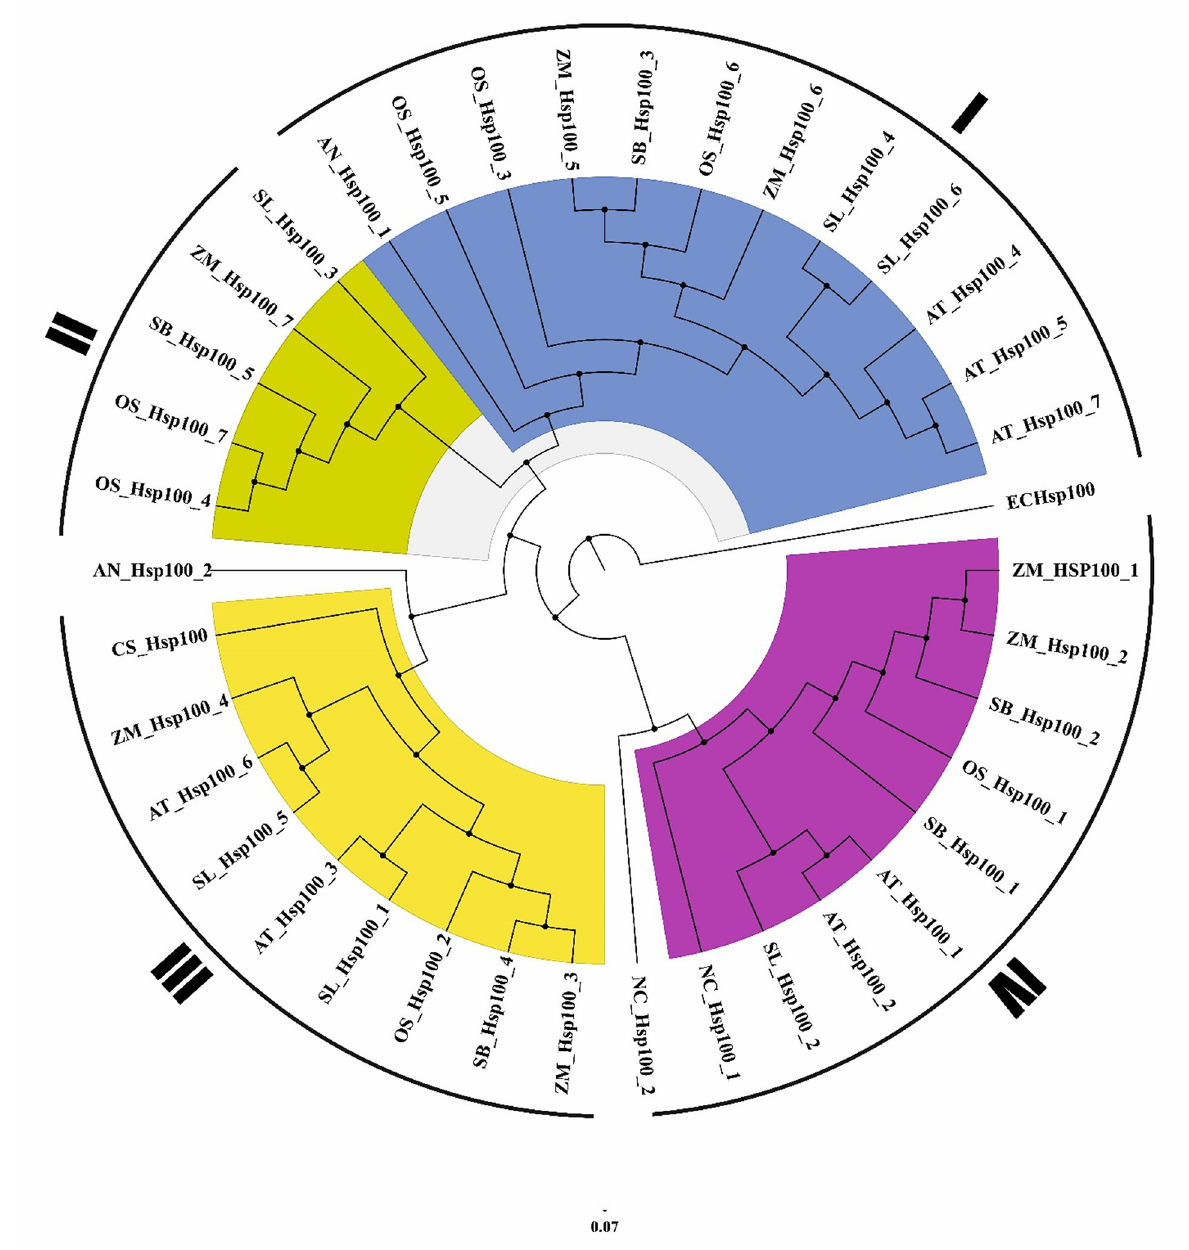
Fig 4. Phylogenetic tree Hsp100 proteins family generated by using ClustalW software programme by neighbor-joining method from the following species: SL = Solanum lycopersicum , AT = Arabidopsis thaliana , ZM = Zea mays , GM = Glycine max , OS = Oryza sativa , CS = Cylindrospermum stagnale , NC = Neurospora crassa , EC = Escherchia coli , AN = Ascophyllum nodosum . The putative Hsp100 genes were divided into 4 clusters.